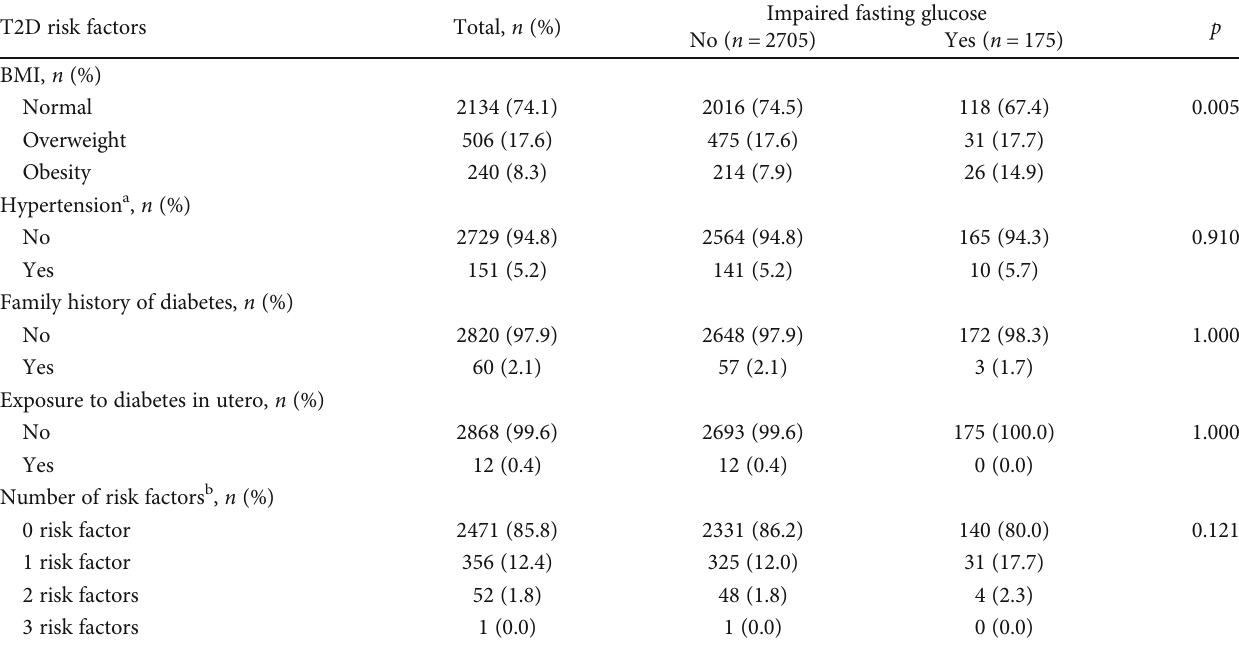
∗ p value of tests to compare the prevalence of prediabetes between groups within region, sex, and age variables. Table 3: Distribution of type 2 diabetes risk factors in total participants and impaired fasting glucose cases. T2D risk